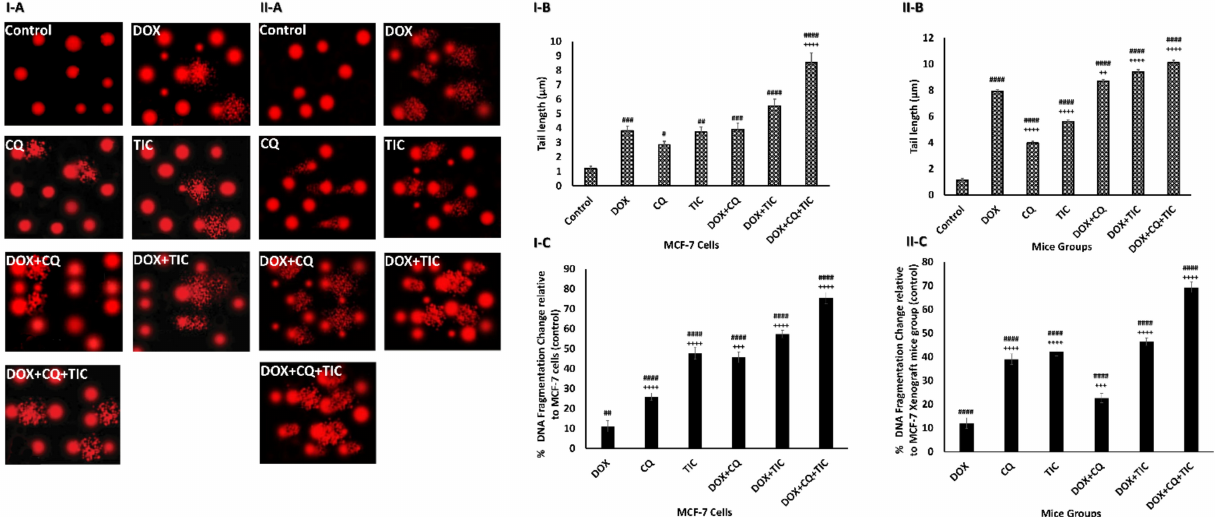
Figure 3. The effect of DOX, CQ, and TIC single or combinations treatments on DNA Damage. Comet assay represents genotoxicity of selected single or combined drugs causing nuclear DNA Damage and photomicrographs of MCF-7 cells ( I-A ) and MCF-7 Xenograft mice ( II-A ). Computed comet tail length ( µ m) representing DNA damage in MCF-7 cells ( I-B ) or MCF-7 Xenograft mice ( II-B ). The percent of fragmented DNA measured colorimetric using Diphenylamine reagent estimated in all treated groups of MCF-7 cells ( I-C ) and MCF-7 Xenograft mice ( II-C ). Results are expressed as mean ± SE ( n = 3). # p < 0.05, ## p < 0.01, ### p < 0.001, #### p < 0.0001 compared with control (untreated group). + p < 0.05, ++ p < 0.01, +++ p < 0.001, ++++ p < 0.0001 compared with the DOX treated